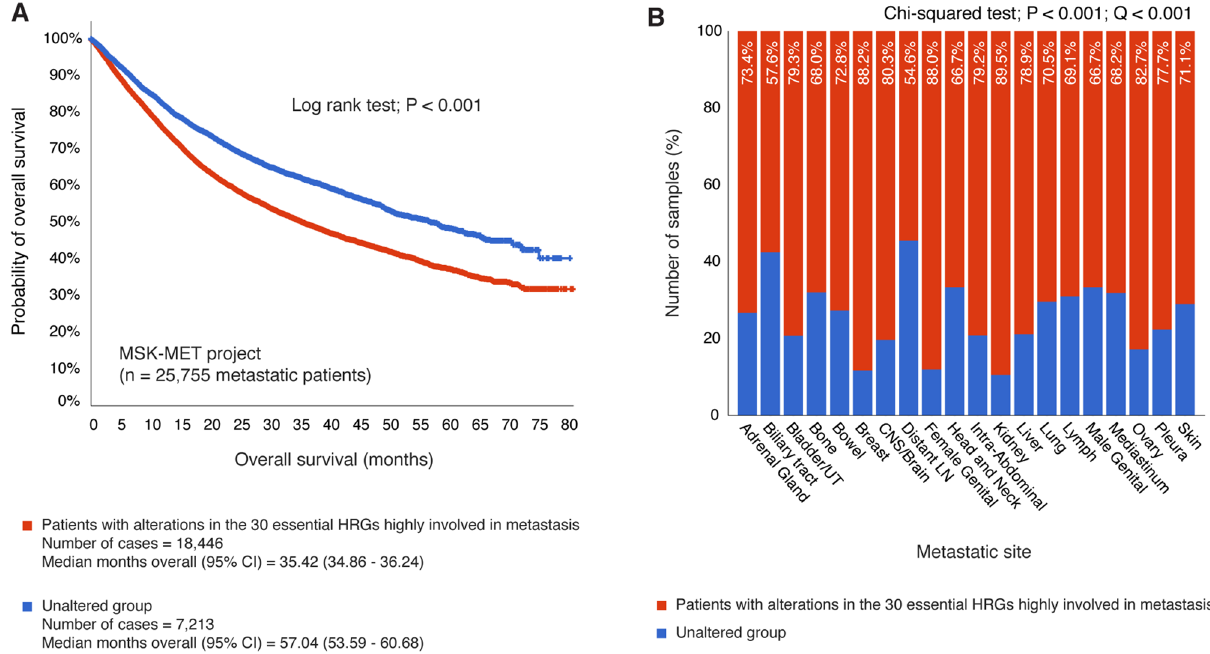
Figure 8. Validation of the essential HRGs through the MSK-MET project. ( A ) Comparison of overall survival between 18,446 patients with alterations in the 30 essential HRGs highly involved in metastasis and 7213 unaltered patients, showing a log rank test P < 0.001. ( B ) Percentage of samples with alterations in the 30 essential HRGs and its respective metastatic site. CNS: Central nervous system; LN: lymph node; UT: urothelial; HRG: hypoxia-related genes; CI: coefficient intervals; MSK-MET: Memorial Sloan Kettering—Metastatic Events and